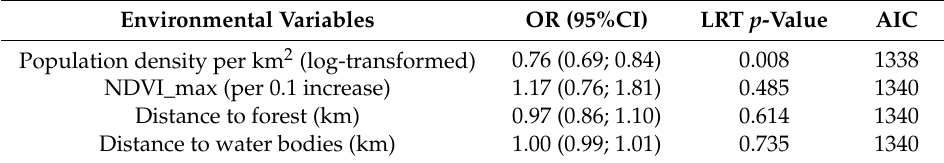
Table 2. Multivariable analysis of the association between CHIKV seroprevalence and environmental variables. The models were adjusted for population density (log-scale) and clustering of individuals in villages (random intercept). Environmental Variables OR (95%CI) LRT p -Value AIC Population density per km 2 (log-transformed) 0.76 (0.69; 0.84) 0.008 1338 NDVI_max (per 0.1 increase) 1.17 (0.76; 1.81) 0.485 1340 Distance to forest (km) 0.97 (0.86; 1.10) 0.614 1340 Distance to water bodies (km) 1.00 (0.99; 1.01) 0.735